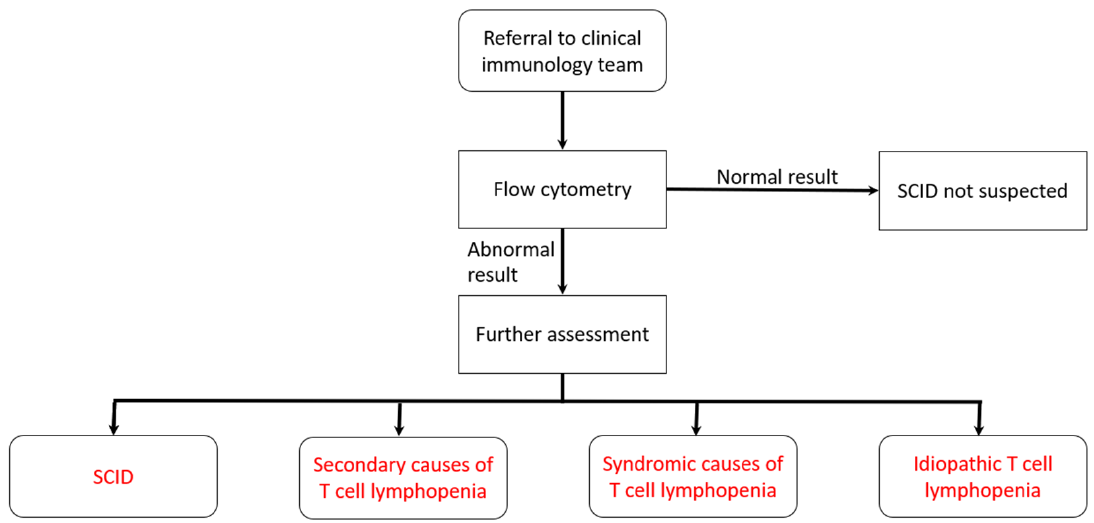
Figure 2. Pathway for babies referred to clinical immunology team (see box for cut-offs).